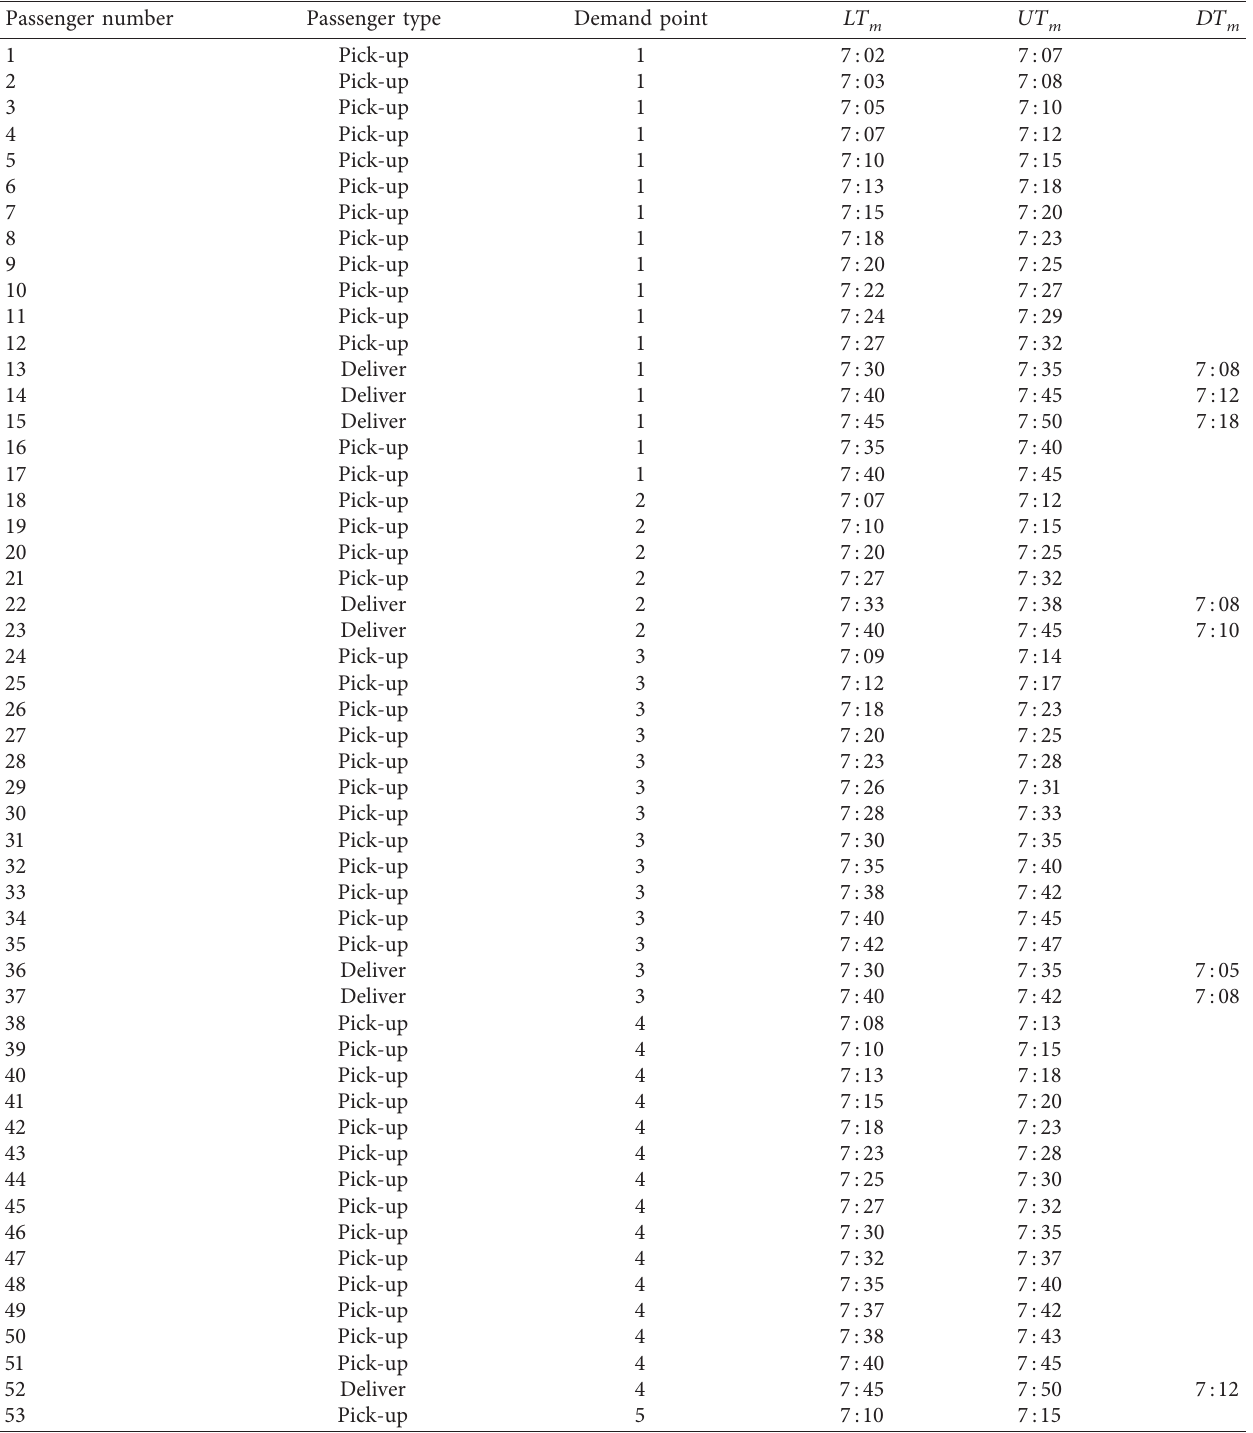
Table 5: Passenger locations and time